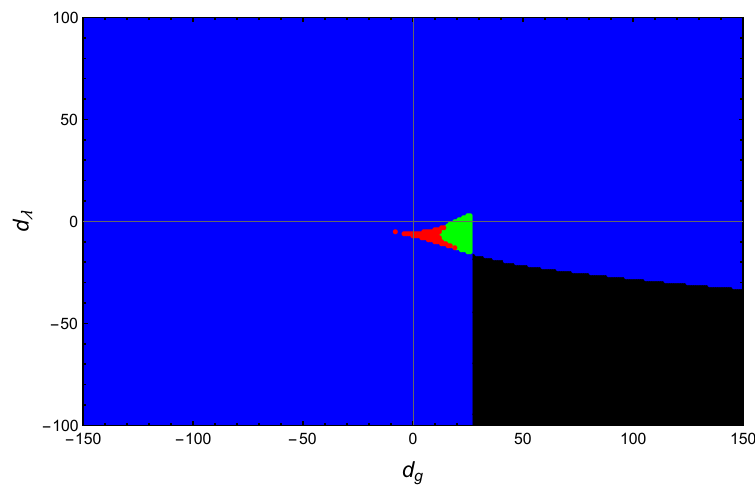
Figure 3 . Number of NGFPs supported by the beta functions (3.23) as a function of the parameters d g and d (cid:21) . The colors black, blue, green, and red indicate the existence of zero, one, two, and three NGFPs situated at g (cid:3) > 0, (cid:21) (cid:3) < 1 = 2, respectively.